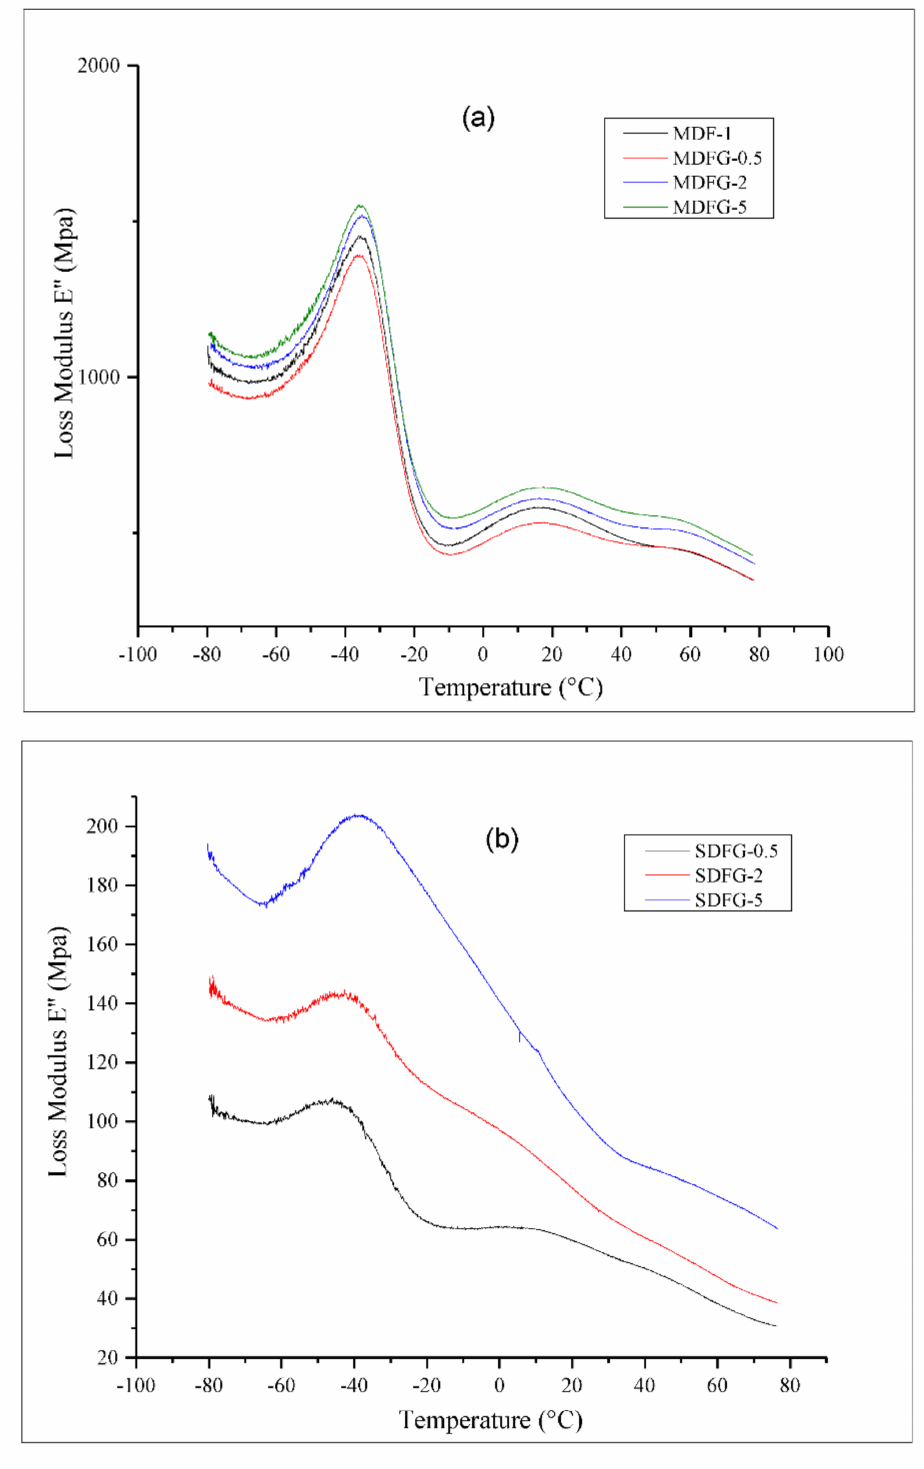
Figure 4. Overlay graphs of loss modulus of nanocomposites: ( a ) prepared by melt-mix method, and ( b ) prepared by solution-cast